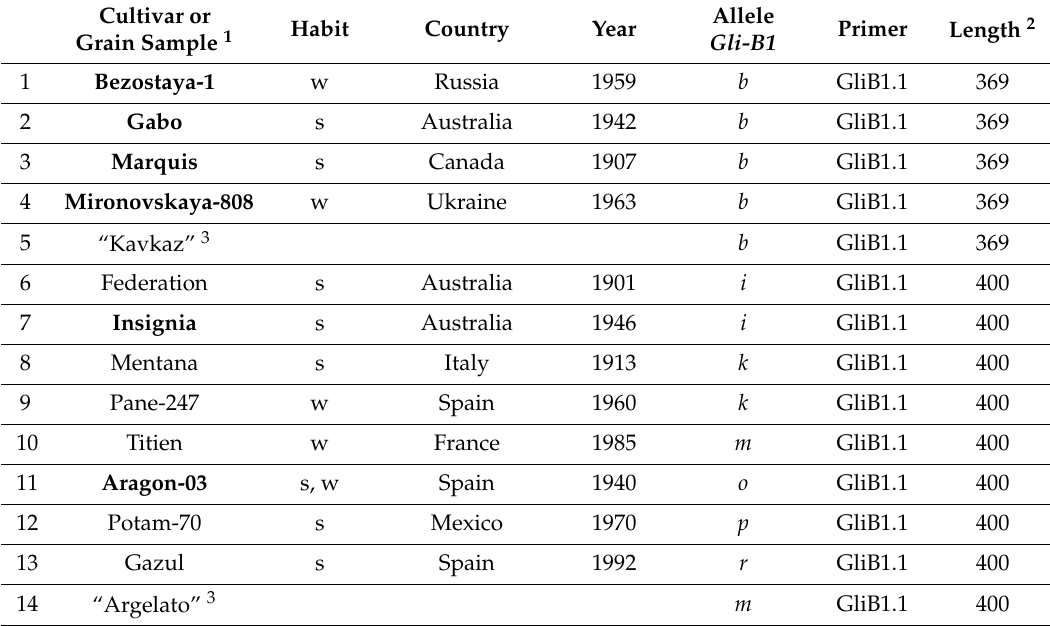
Table 1. Cultivars (grain samples) studied and their habit, country of origin, year of release, Gli-B1 allele, and the approximate length of the PCR product